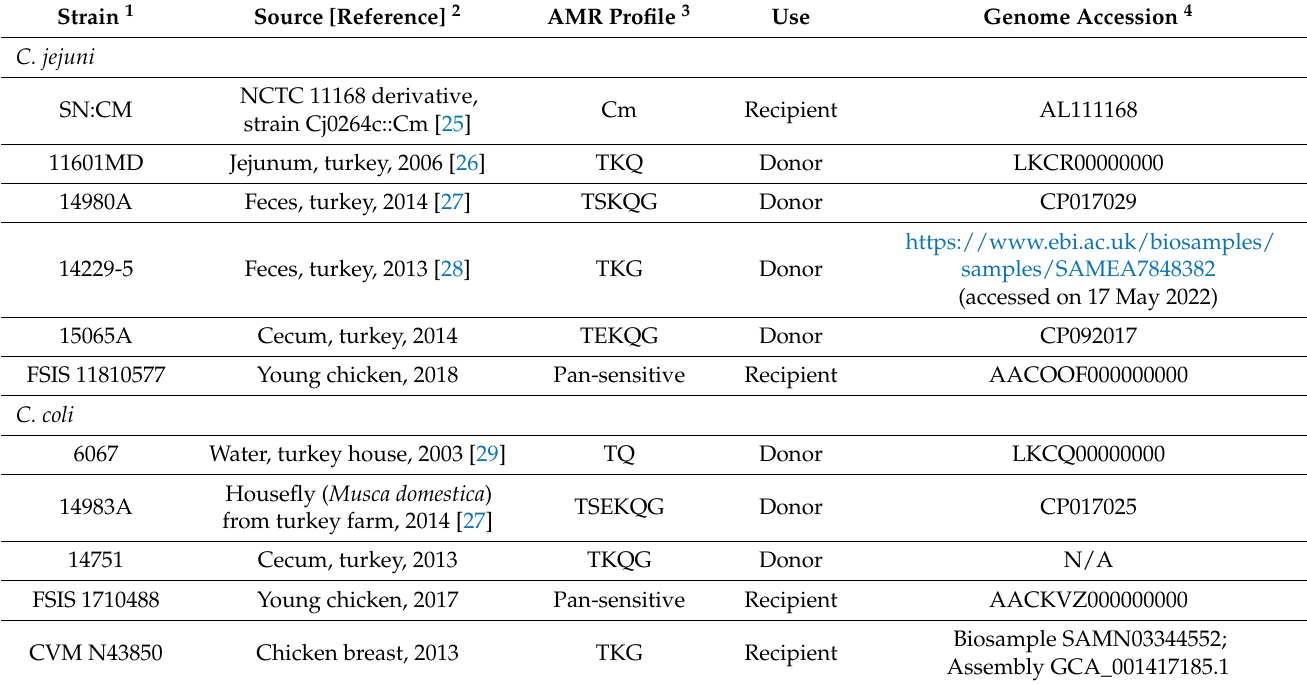
Table 1. Campylobacter strains used in this